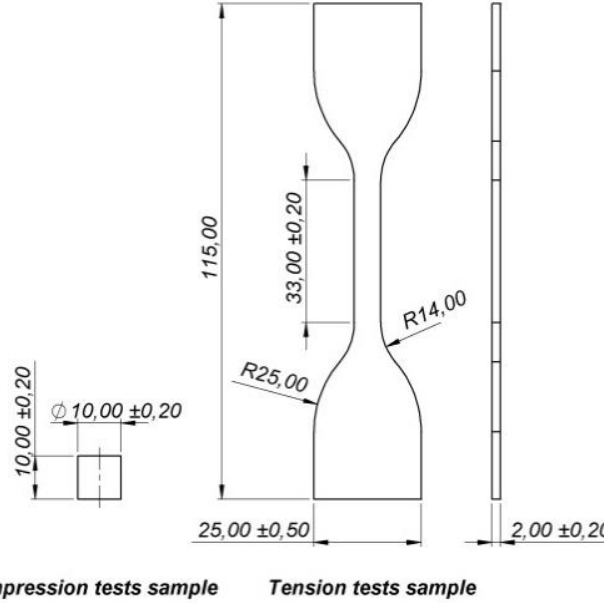
Figure 11. The view of the samples used during the determination of the mechanical properties of the TPU material under uniaxial compression and tensile tests.